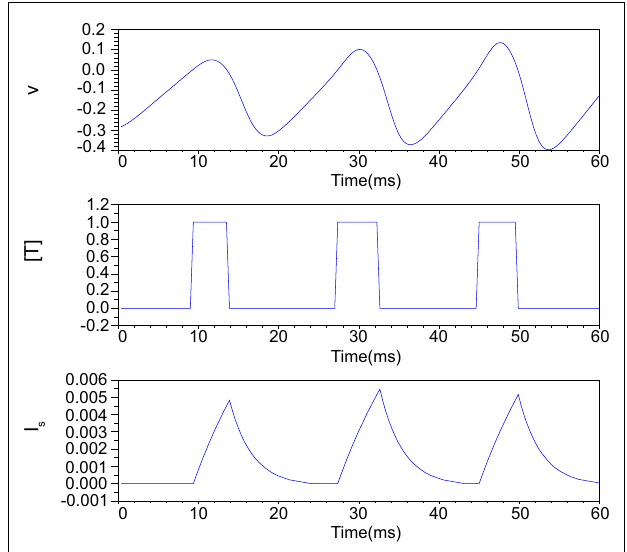
FIGURE 2 | Numerical simulation of postsynaptic current generation of the Class II neuron. I stim = 0.04 when 0 < t ≤ 18.75ms; I stim = 0.06 when 18.75 < t ≤ 37.5ms; I stim = 0.08 when t > 37.5ms, α = 83.3, β = 333.3.